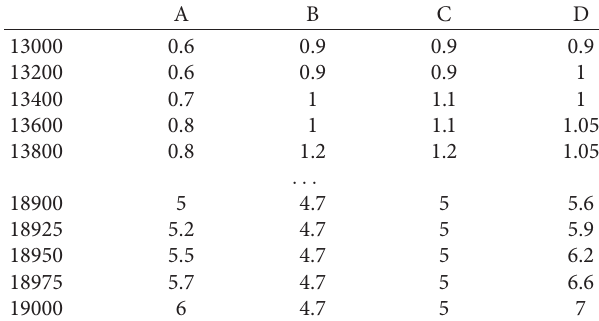
Table 6: Partial test data of constant amplitude two-hole test specimen 03.